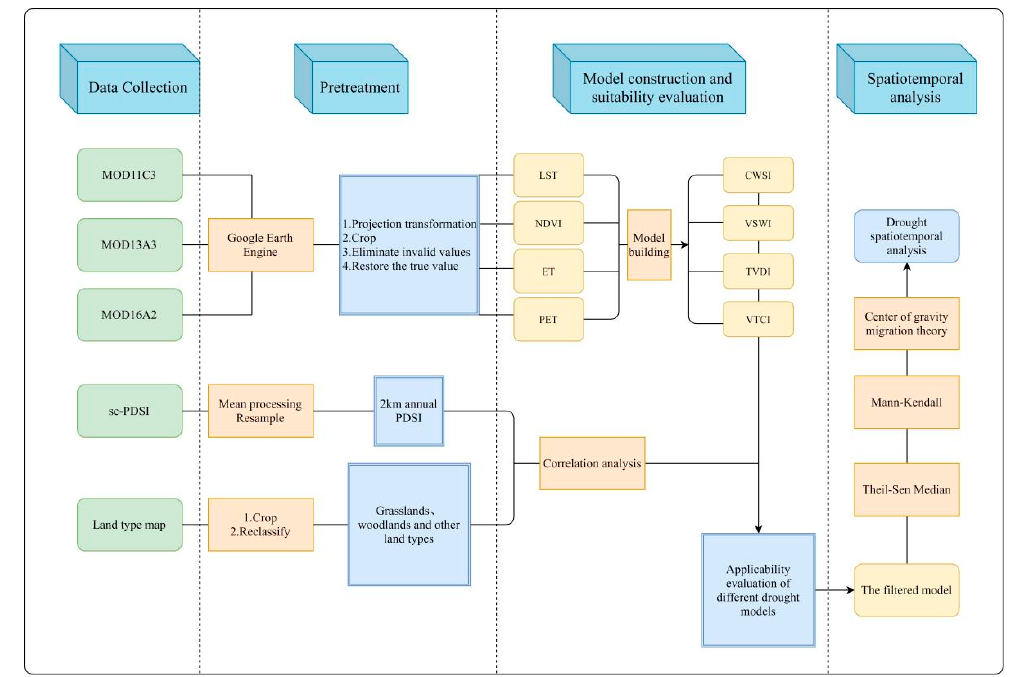
Figure 2. Flowchart of drought estimation based on MODIS remote sensing data.